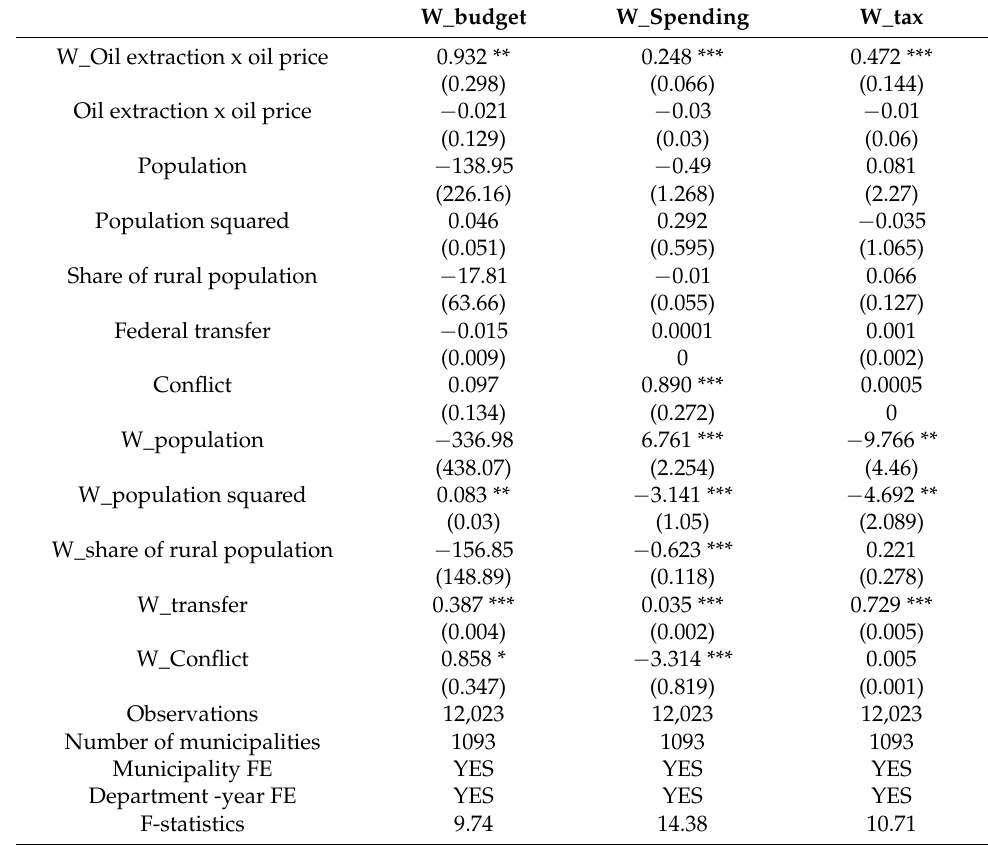
Table 4. First stage regression